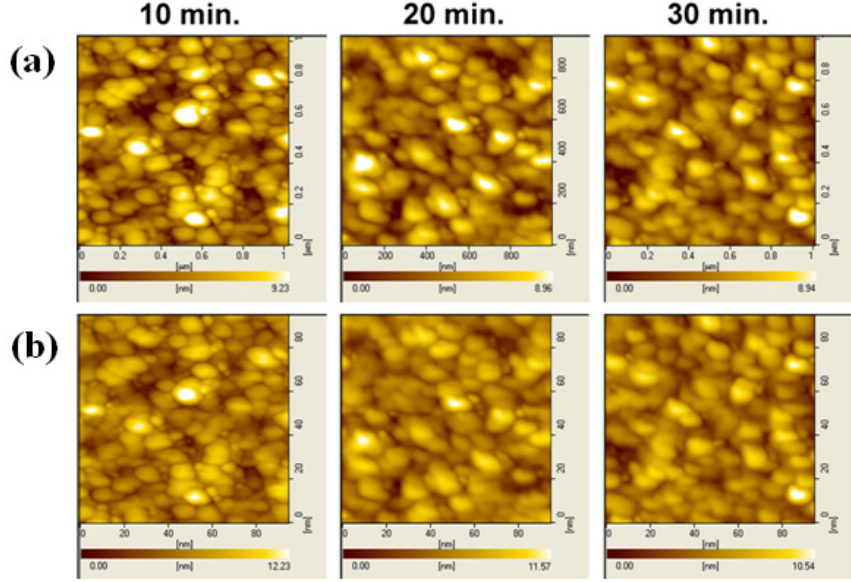
Figure 8. Annealing time-dependent AFM surface morphology images of (a) thermal annealing, and (b) UV annealing of the pH-sensitive PSW sensors coated with γ